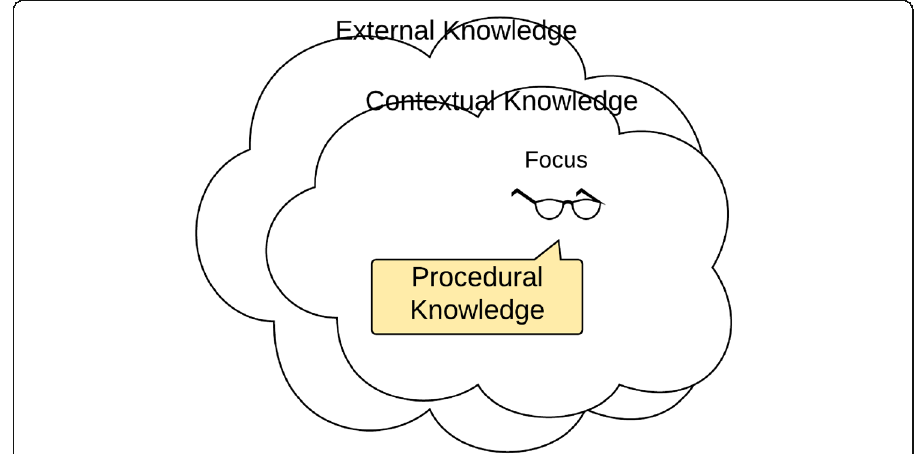
Fig. 2 Different kinds of context knowledge (based on Brézillon & Pomerol,